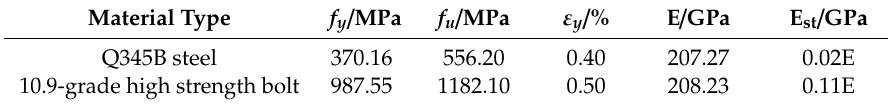
Figure 17. Material constitutive model: ( a ) Steel constitutive model; ( b ) Bolt constitutive model. Table 7. Bolt and steel material properties.